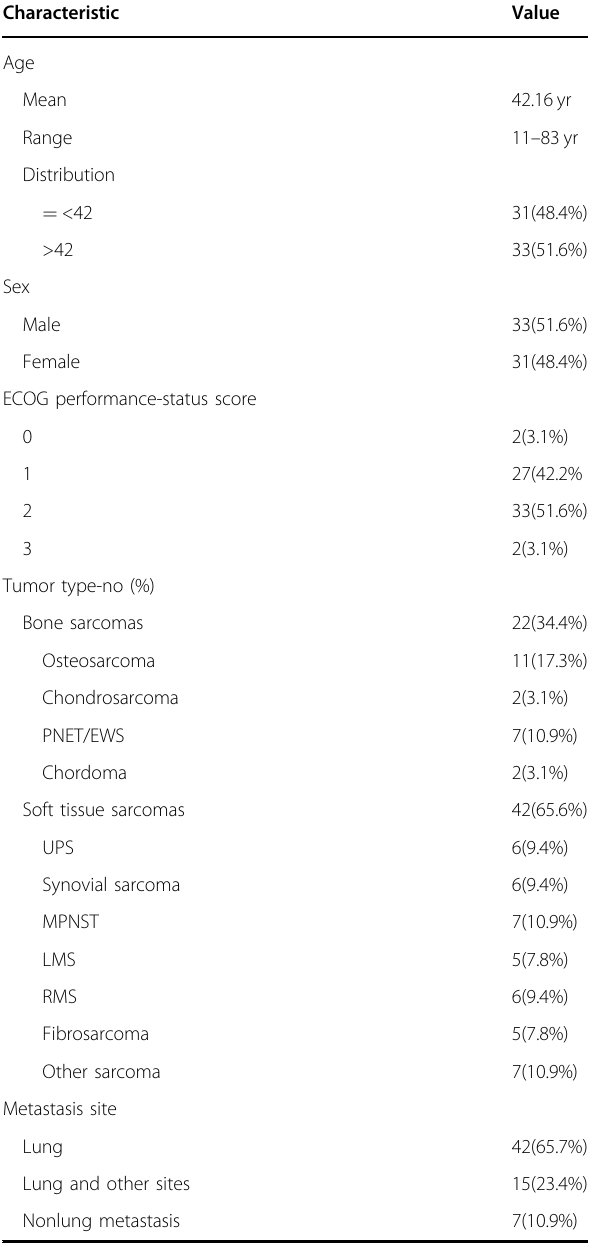
Table 1 Clinicopathological characteristics of patients with sarcoma treated with